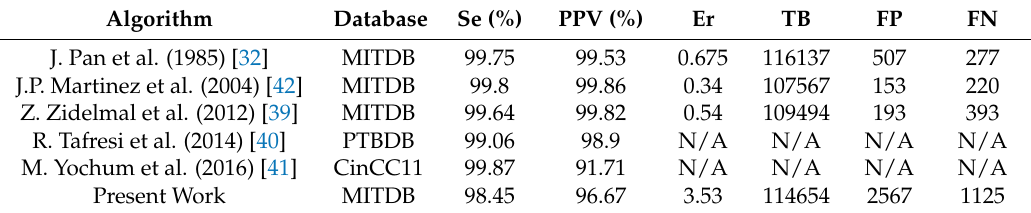
Table 2. Comparative analysis between different QRS detection